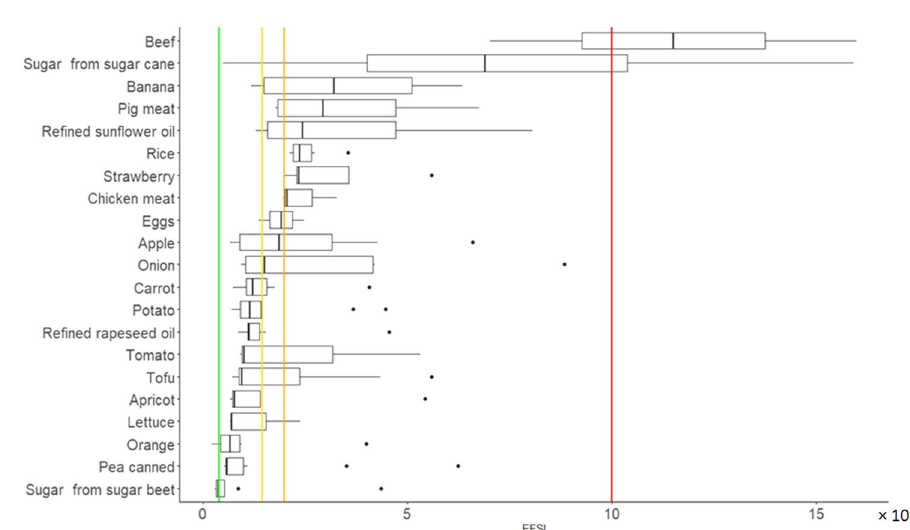
Fig. 4 Distribution of EFSI result of the N 2 = 149 hypothetical food items. Colored lines represent threshold values for the categorization. Being the green line the established threshold value (4.00 × 10 − 4 ) between very-low and low impact; Yellow line the threshold value (1.45 × 10 − 3 ) between low and medium impact; Orange line the threshold value (2.00 × 10 − 3 ) between medium and high impact; and Red line the threshold value (1.00 × 10 − 2 ) between high and very-high